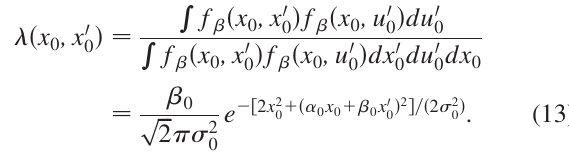
FIG. 4. (Color) The distribution of the impact positions of lost 208 Pb 81 þ ions (green dots) from BFPP after IP2 in the LHC, as simulated by tracking 10 4 particles, shown together with the beam screen.